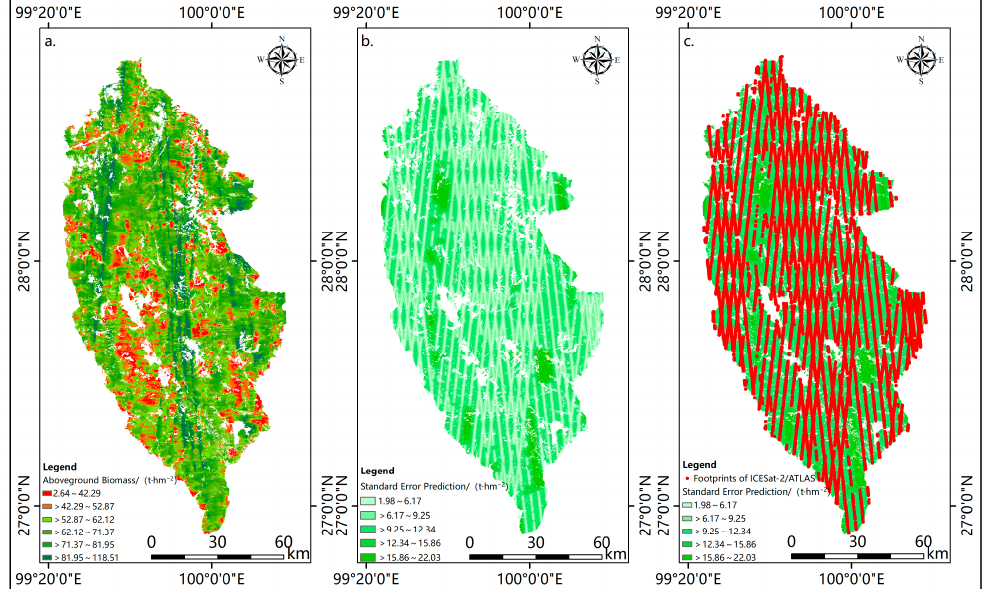
Figure 11. Spatial distribution of AGB in the study area. ( a ) Predicted results. ( b ) Standard error prediction. ( c ) Standard error of overlapping footprint prediction results.